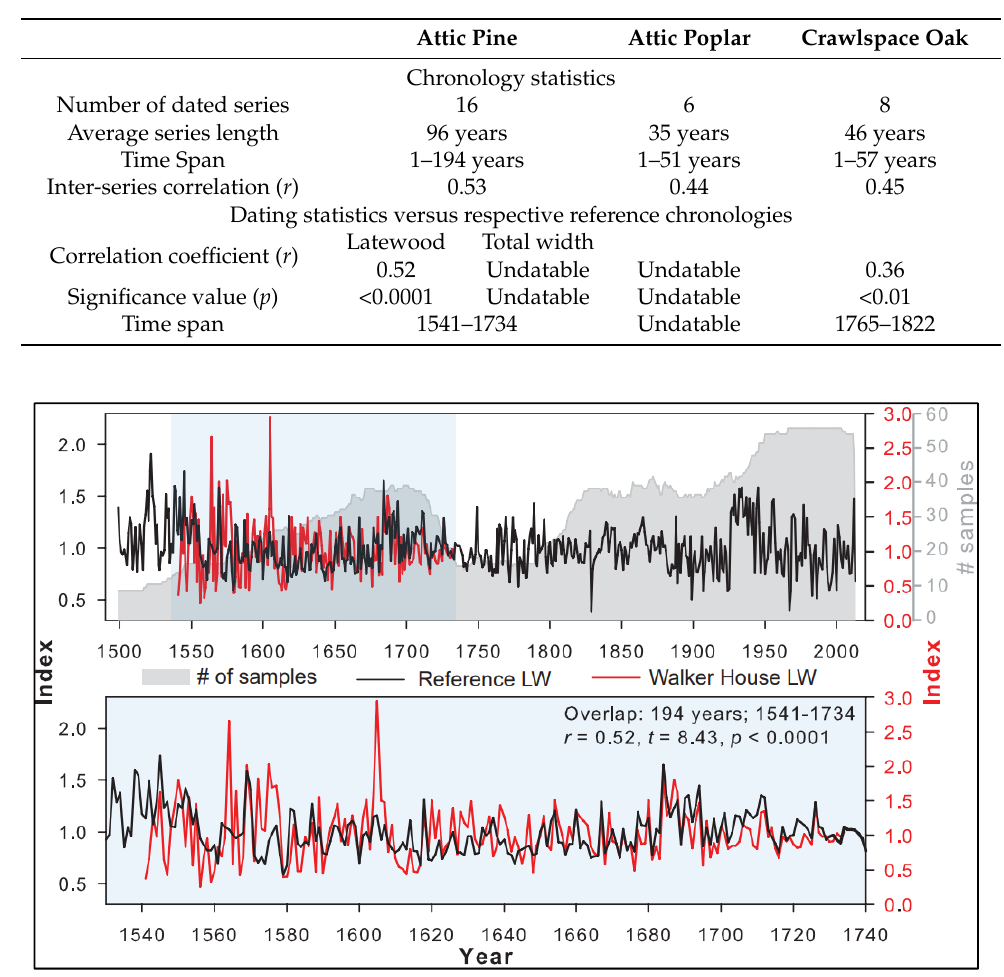
Figure 5. The Walker House latewood-width (LW) chronology (red) plotted with the longleaf pine LW reference chronology (black). Top panel shows the temporal placement of the Walker House chronology against the entire reference chronology, and the bottom panel shows a zoomed inset. The Walker House chronology is anchored in time against the reference chronology from 1541 to 1734 ( n = 194 years, r = 0.52, t = 8.43, p <